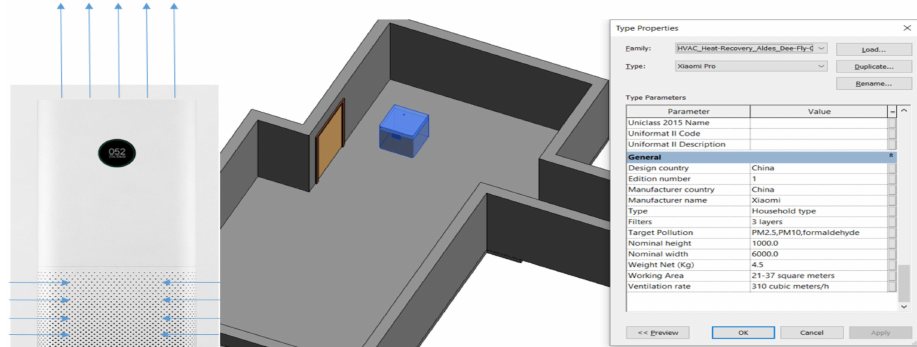
Figure 3. BIM model of the selected air purifier and corresponding properties.